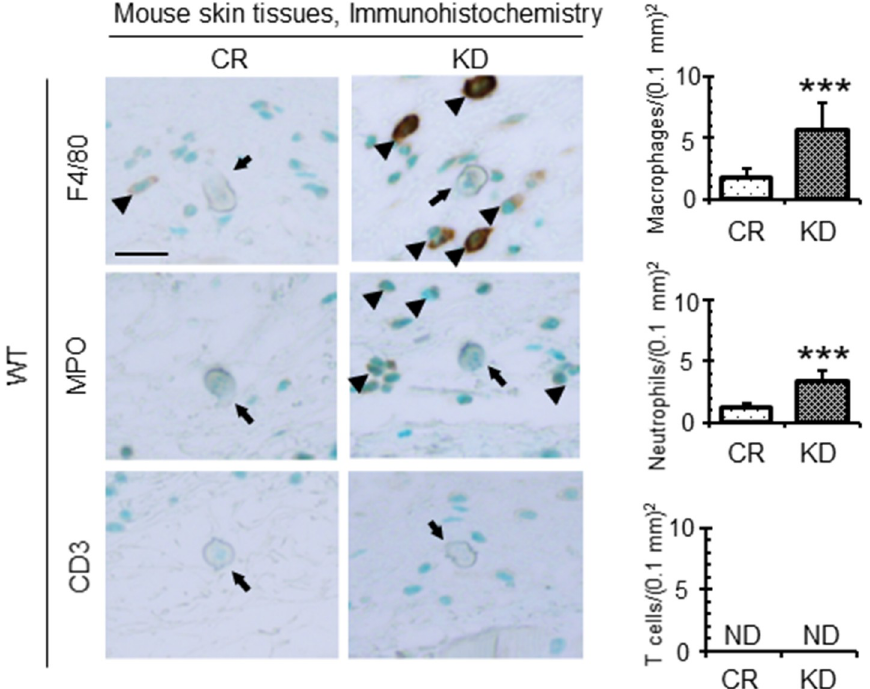
Fig 9. Endogenous venestatin suppressed the accumulation of macrophages and neutrophils around S . venezuelensis . Immunohistochemical analysis of skin tissues from wild-type (WT) mice was performed. Skin tissues were collected from the larval inoculation site at 6 h p.i. with 2,000 LL3s treated with ds luciferase (CR) or ds venestatin (KD). The sections were subjected to immunostaining using anti-F4/80 (macrophages), anti-MPO (neutrophils), or anti-CD3 (T cells) antibodies, and positive cells (arrow heads) around the larvae (arrows) were then counted. Scale bar: 25 μ m. Data are expressed as means ± SDs of 12 fields from two mice. ��� p < 0.0001. ND, no